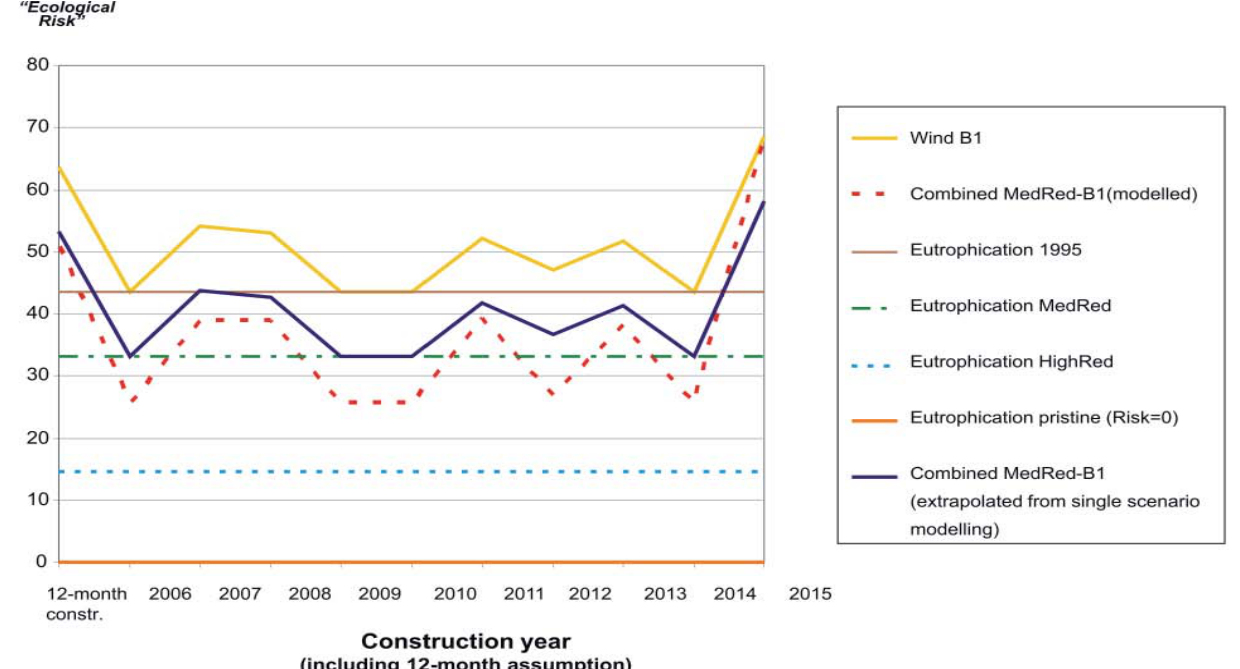
Figure 7. ‘ Ecological risk‘ calculated with respect to minimum and maximum values of indicators throughout all scenari- os, but excluding the combined scenario. For explanation see